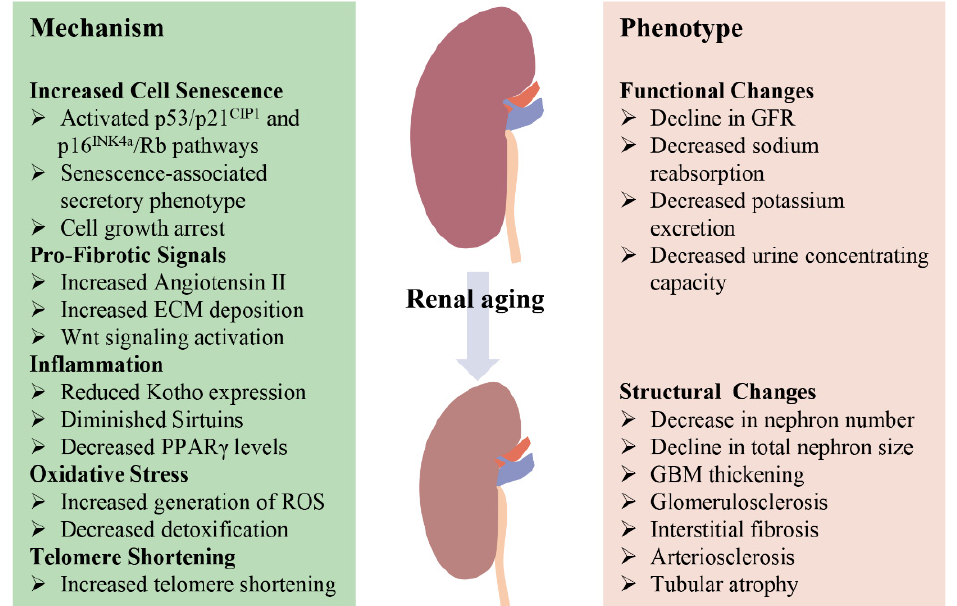
Figure 1. Schematic diagram of the main mechanisms and phenotype of renal aging. With increasing age, there are significant changes in both the function and structure of the kidney. Multiple age-related pathways contribute to altered renal outcomes in the